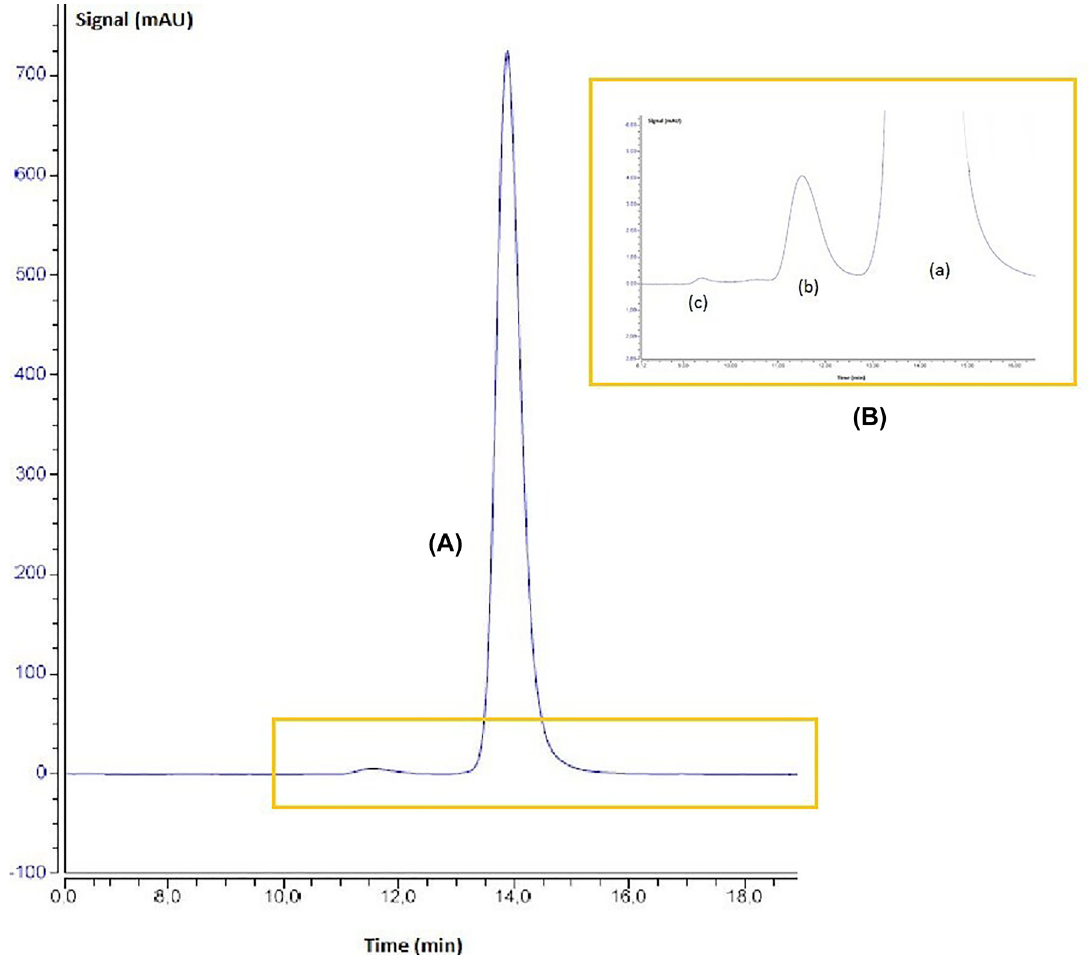
Figure 3: Part A: Typical Bevacizumab chromatogram obtained by SEC: Bevacizumab presents three peaks, one of which is very dominant and is considered to be the monomer, one of which is considered to be a dimer and one of which is a high molecular weight peak. Part B: Magni fi cation of the chromatogram: the monomer accounts for more than 99% (a). An additional high molecular weight peak is observed (b): dimer and high molecular weight peaks